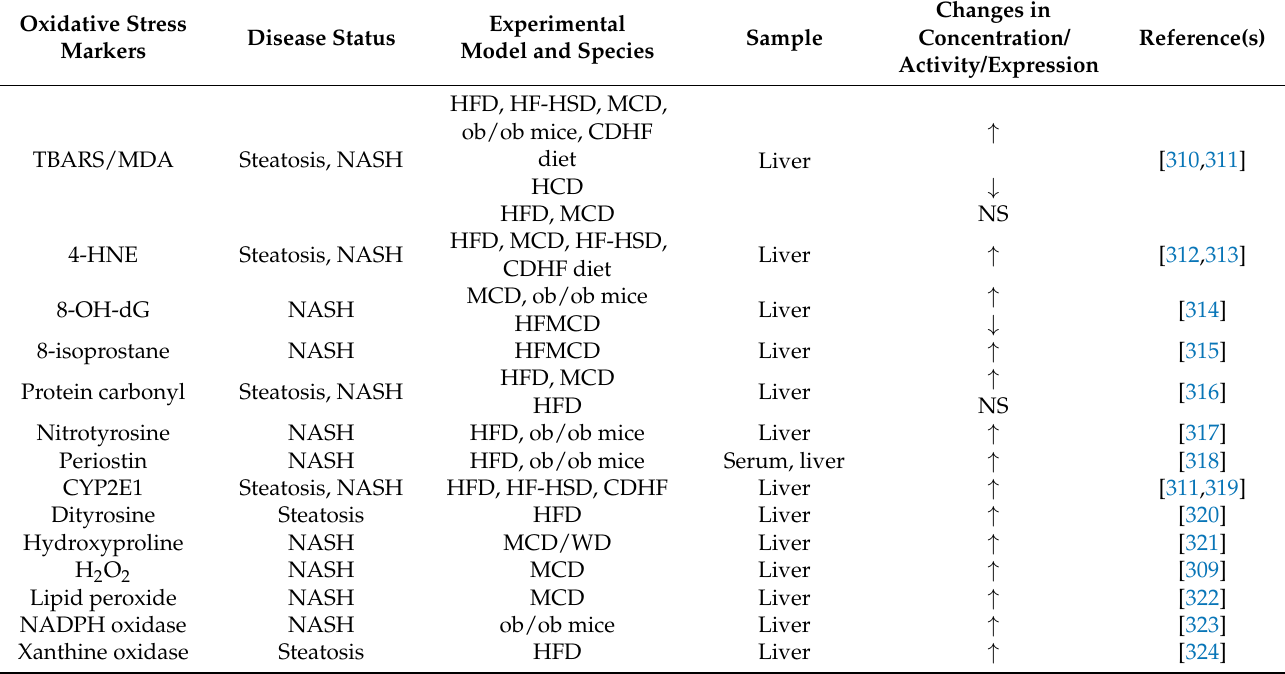
Table 1. Oxidative stress markers in animal models of